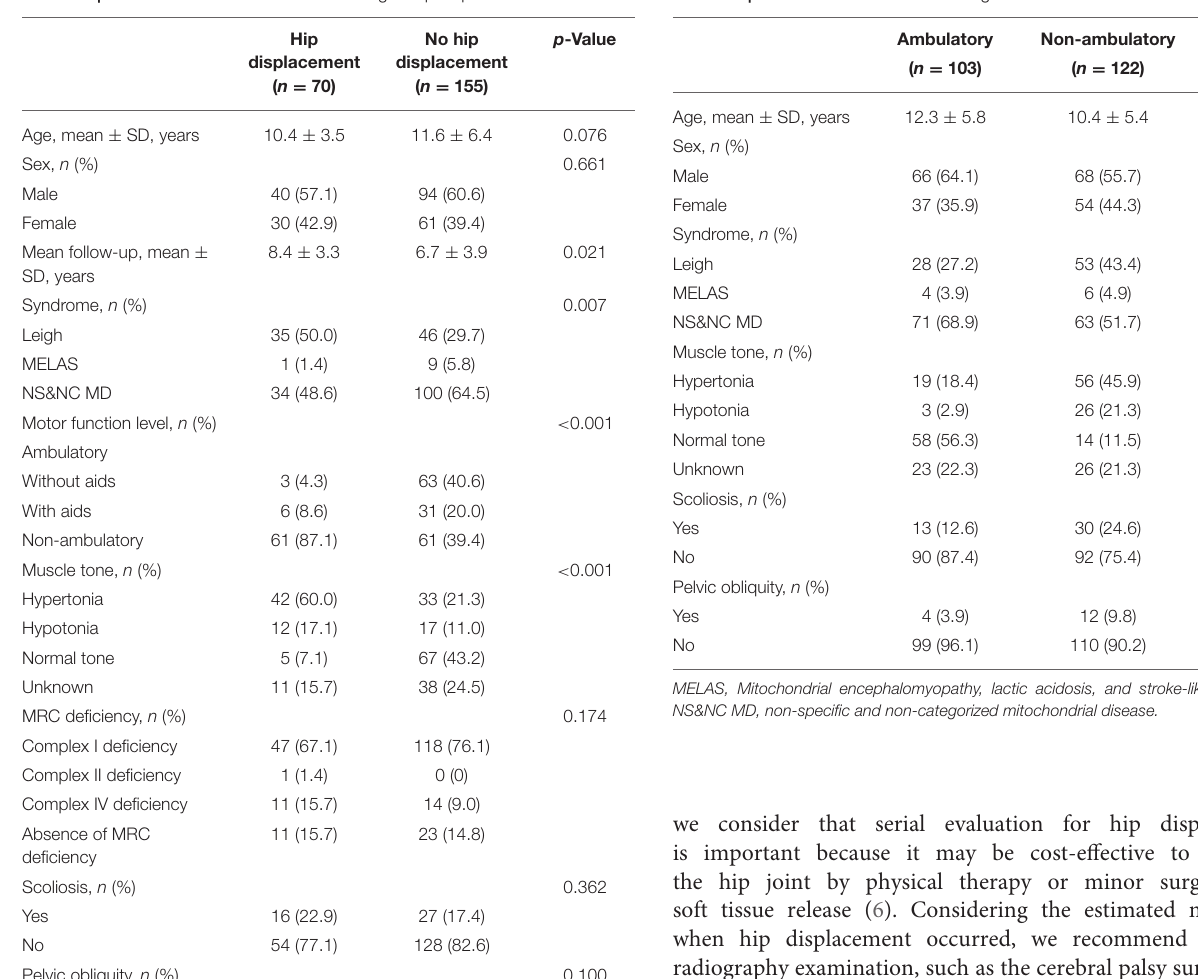
TABLE 1 | Distribution of the variables according to hip displacement. TABLE 2 | Variables distribution according to